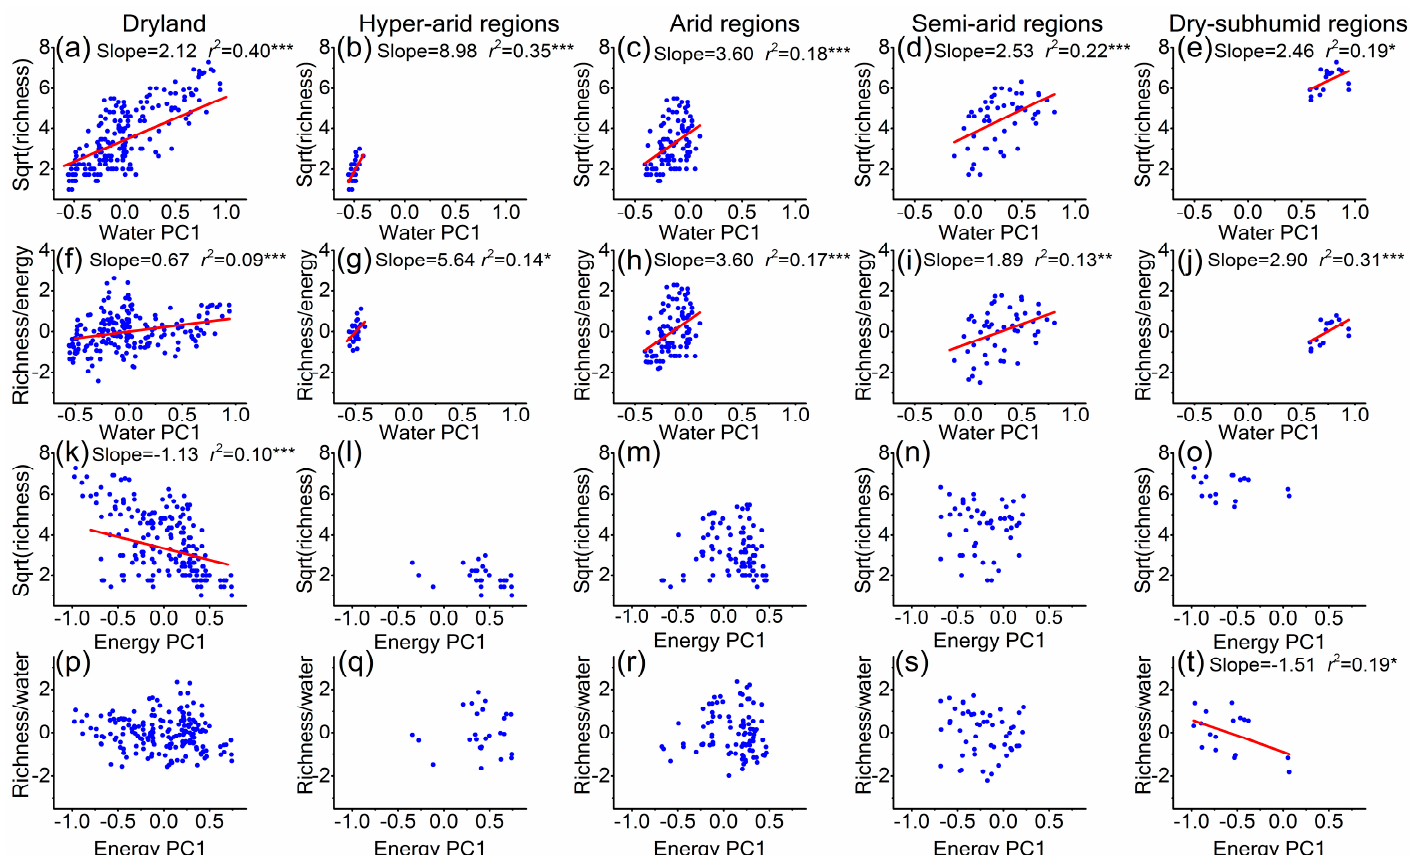
Figure 3. The relationship between ( a–e ) overall plant diversity and water; ( f–j ) plant diversity conditioned on energy (richness/energy) and water; ( k–o ) overall plant diversity and energy; ( p–t ) plant diversity conditioned on water (richness/water) and energy across the entire dryland in China and the different aridity regions. Only significant trend lines ( p < 0.05) are fixed. Plant diversity is expressed as the number of species in 900 m 2 in each site and is square-rooted in models, and r 2 is the adjusted coefficient of determination. Dryland: n = 184 sites; hyperarid regions: n = 26 sites; arid regions: n = 91 sites; semiarid regions: n = 50 sites; dry-subhumid regions: n = 17 sites.